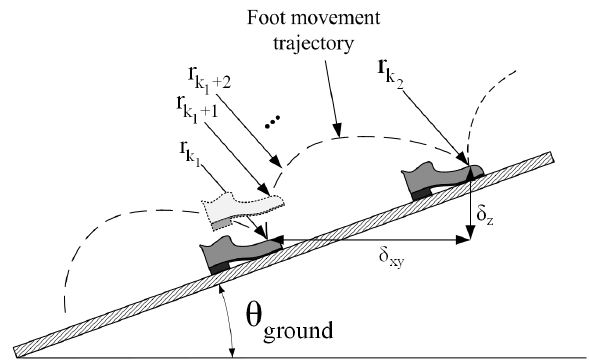
Figure 3. Foot movement between two zero velocity